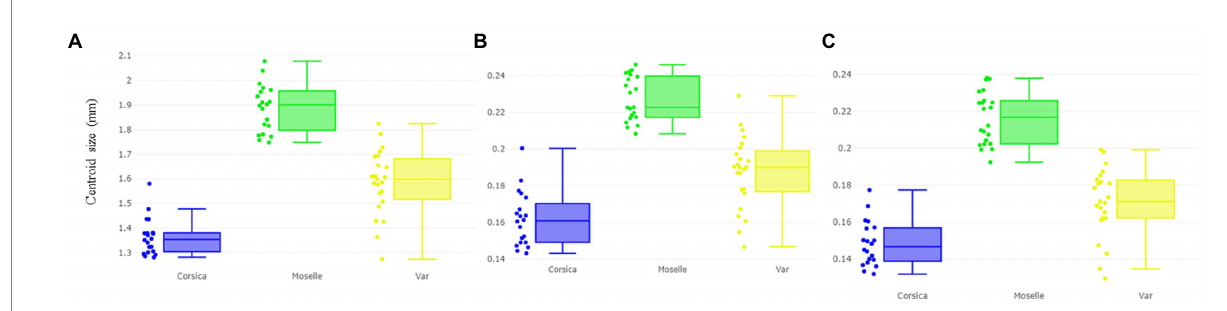
FIGURE 4 Boxplot illustrating wing size (centroid size, CS) variation based on the landmarks (A) , outlines-1 (B) outlines-2 (C) sets of Culicoides circumscriptus from three different sampling sites (Corsica, Moselle, and Var). Expand: median, percentile, and outliers.